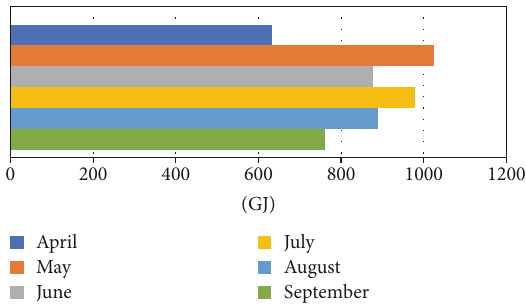
Figure 15: Heat loss in the solar fi eld at sunny periods.